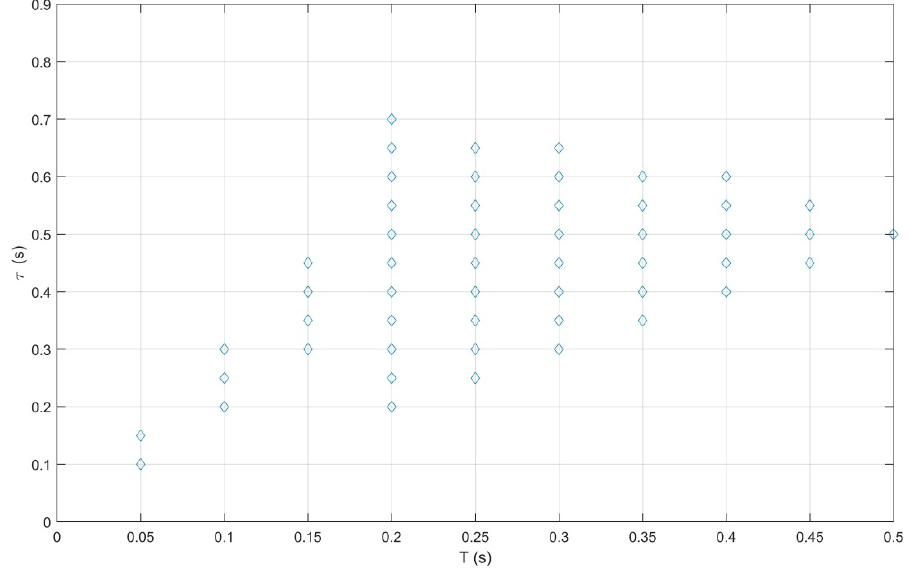
Figure 18. Stabilization ranges of sampling period and sampling delay ( m = 2 ).